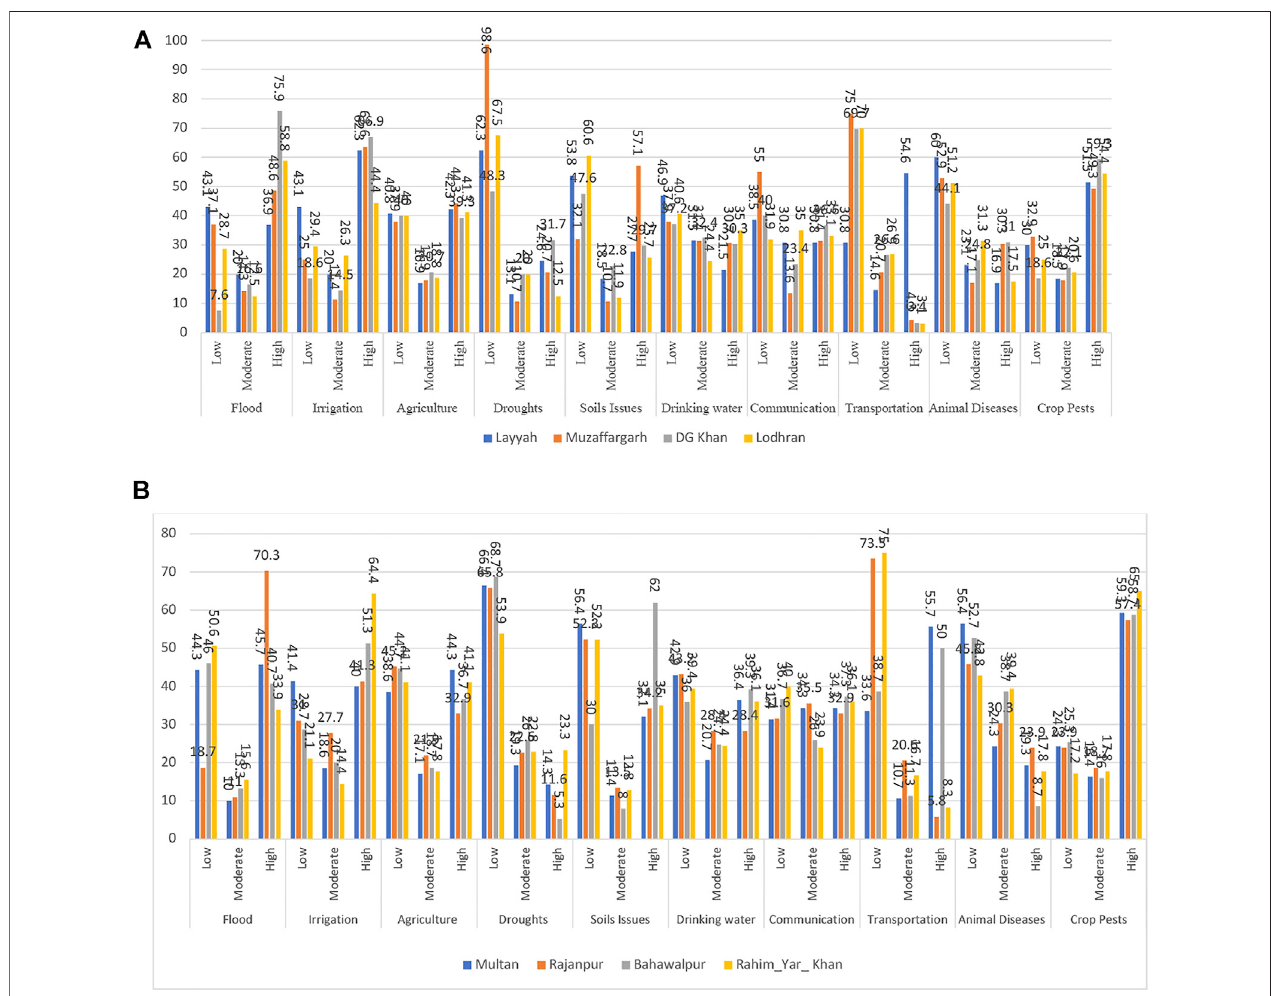
FIGURE 3 | Determining factors of Climate Change (%) in South Punjab